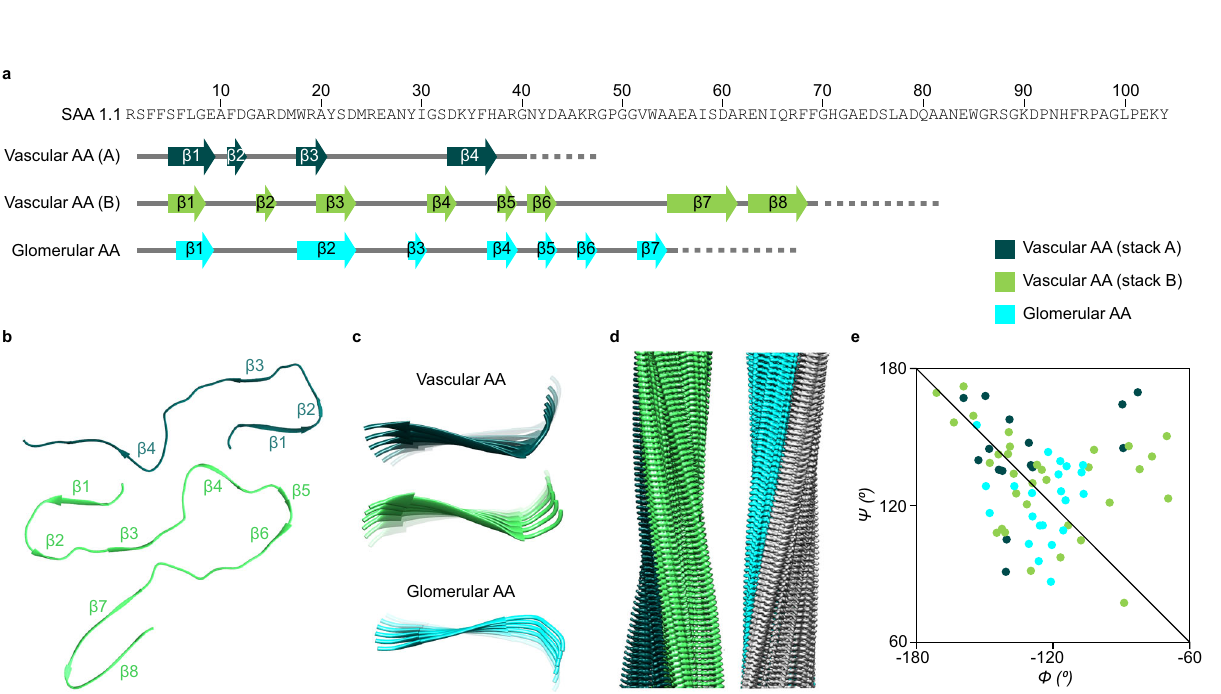
Fig.3| β -sheetstructureinthevascularandintheglomerular fi bril.a Sequence of SAA1.1 shown side by side with schematic representations of the fi bril proteins fromthevascular(stacksAandB)andglomerular fi bril.Continuousgraylines: fi bril core segment; dotted lines: disordered segments; arrows: β -strands. b Ribbon diagramofonemolecularlayerofthevascular fi bril. β -strandsarelabeledwith β 1to β 8. c Ribbondiagramofresidues2 – 10oftheglomerularandvascular fi bril(stacksA andB)showingthedifferenttwistsofsheet β 1.Onlyeverythirdmoleculealongthe